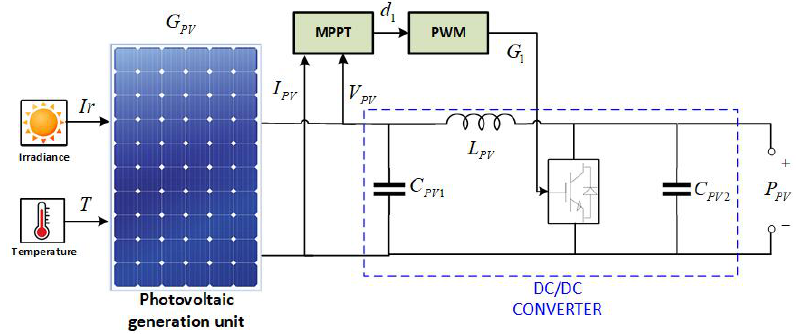
Figure 3. Control design for the photovoltaic system.